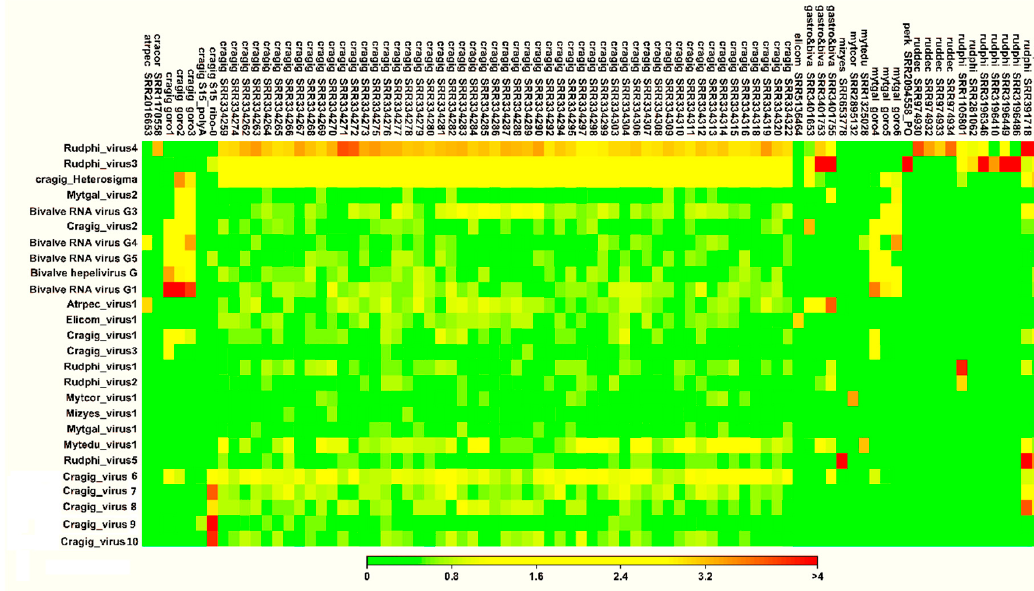
Figure 2. Coverage heat map for the 26 bivalve-associated viruses over 82 RNA-seq samples with at least 1000 viral reads. Data are reported as log 10 , as depicted in the colored scale. Raw data are reported in Supplementary Table 3.